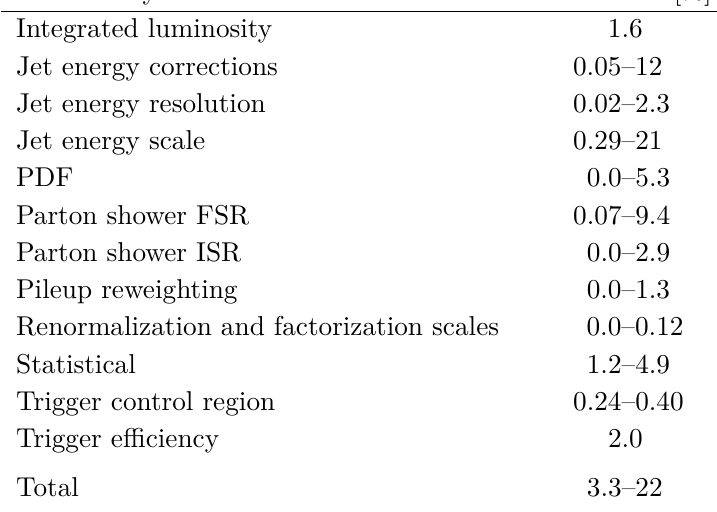
Table 4 . The range of effects on the signal yield for each systematic uncertainty and the total. Values less than 0.01% are rounded to